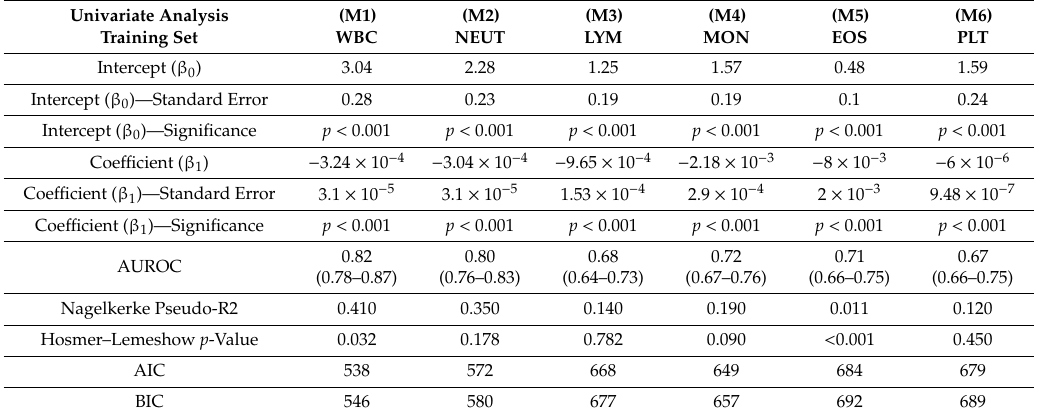
Table 3. Univariate Analysis. Intracohort statistically significant values were studied